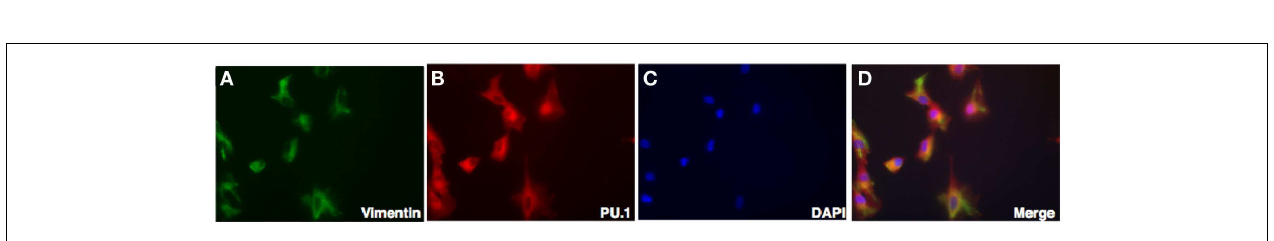
FIGURE 4 | Confocal microscopy of the decidual cells expressing PU.1 transcription factor in the cytoplasm and nucleus . Decidual cells fixed, permeabilized, immunostained with rabbit anti-human PU.1